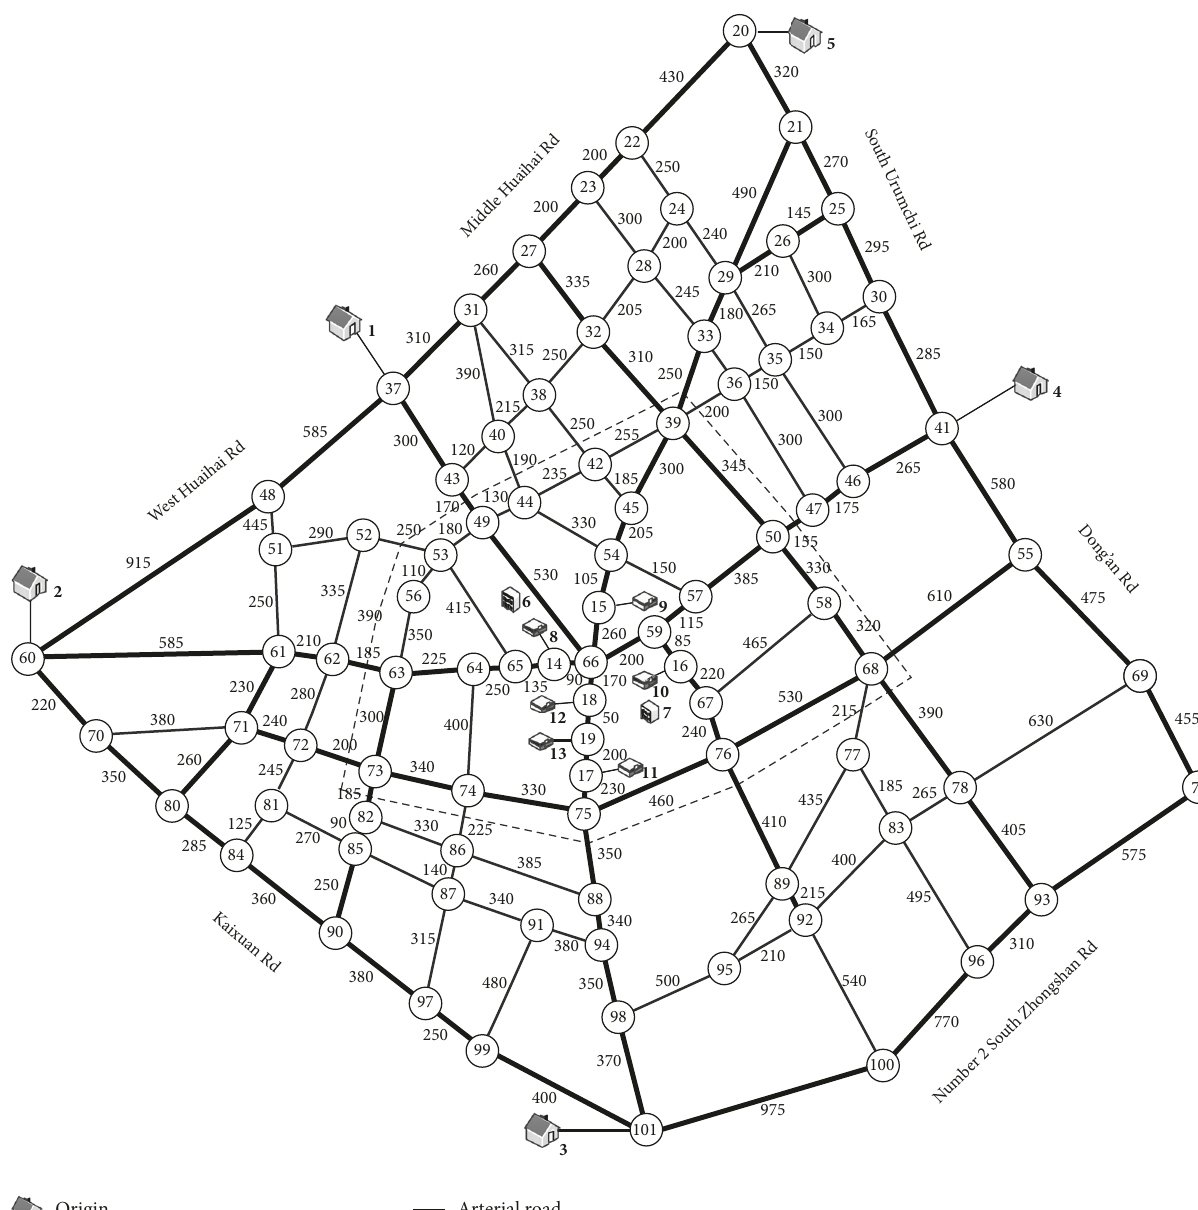
Figure 5: Network of Xujiahui CBD, Shanghai,